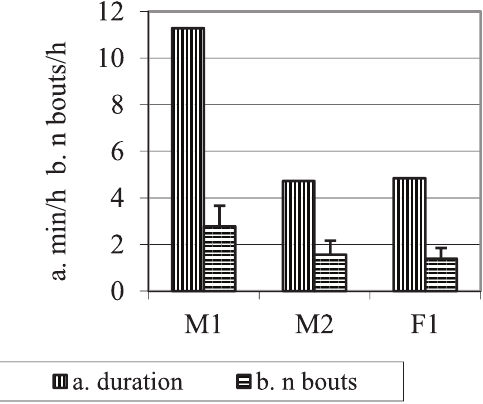
Figure 2. a . Duration of guarding (minutes/h) and b . number of guarding bouts/h by M